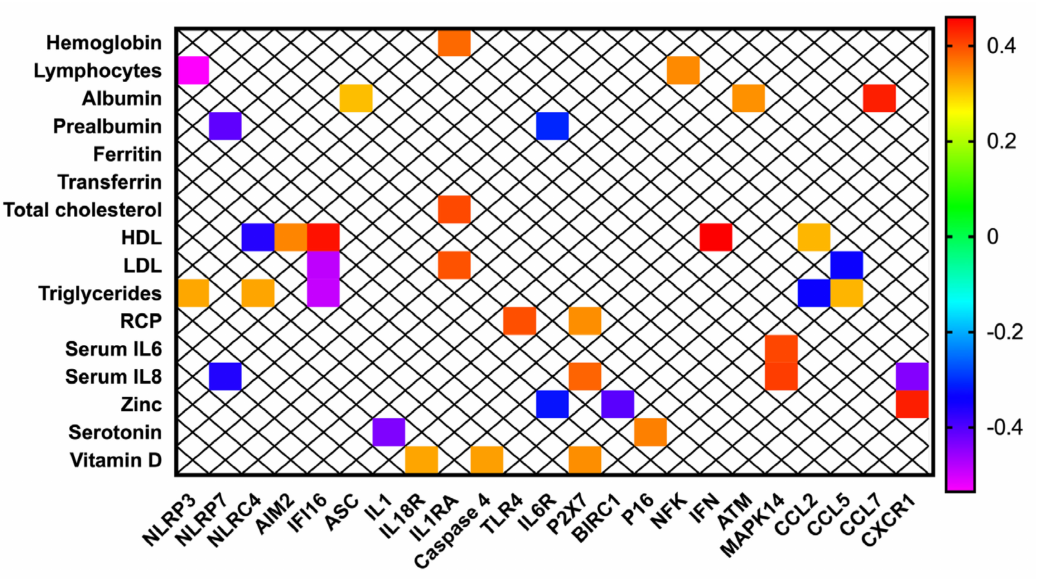
Figure 4. Correlations between biochemical and molecular parameters of the nutritional evaluation in patients with head and neck